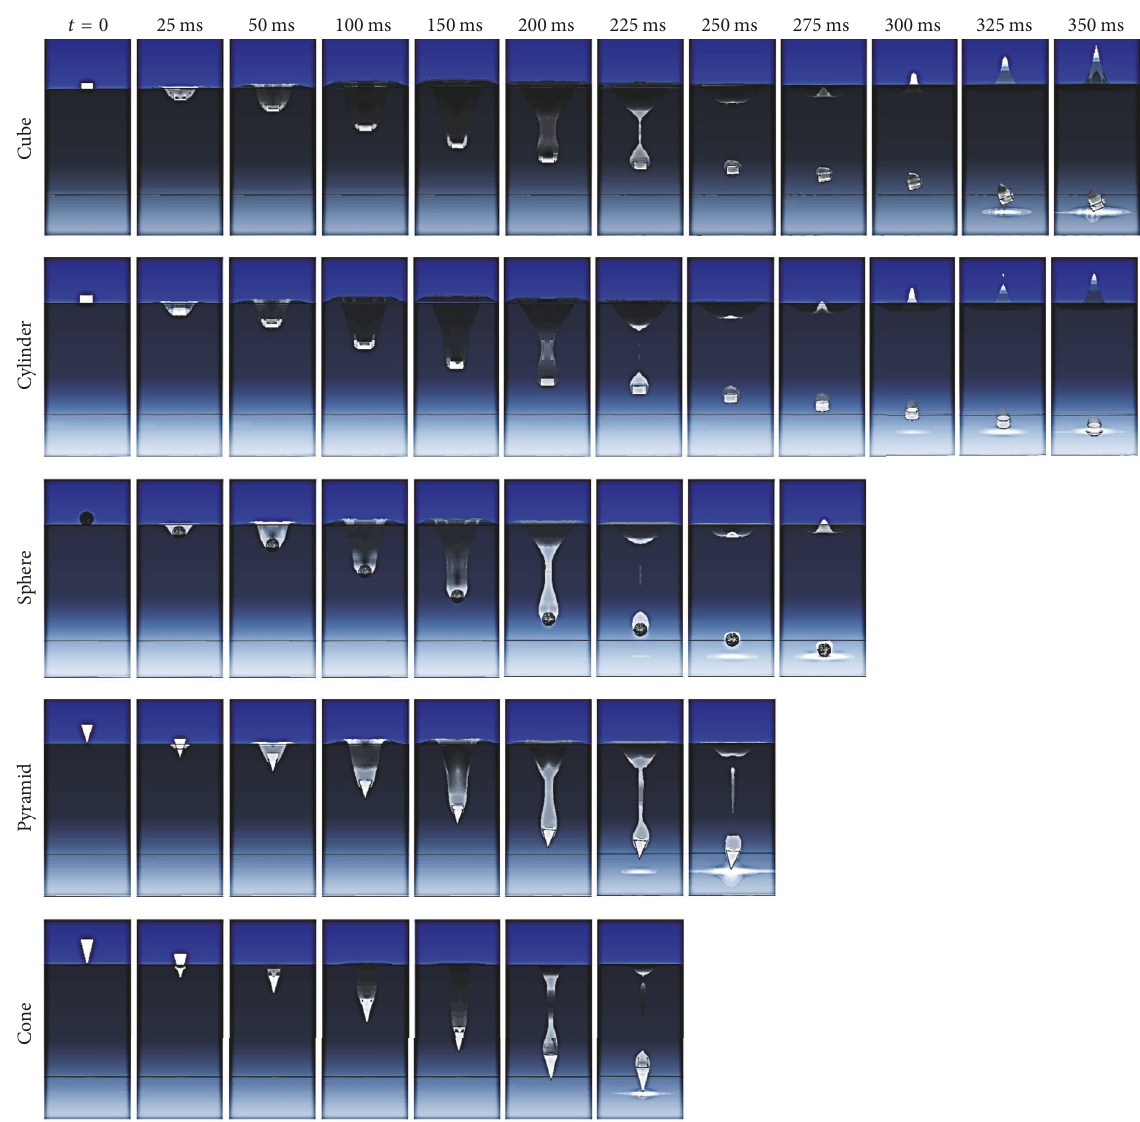
Figure 10: Air cavity formation due to deepwater movement of pounders with different geometric shapes and pinch-off time and